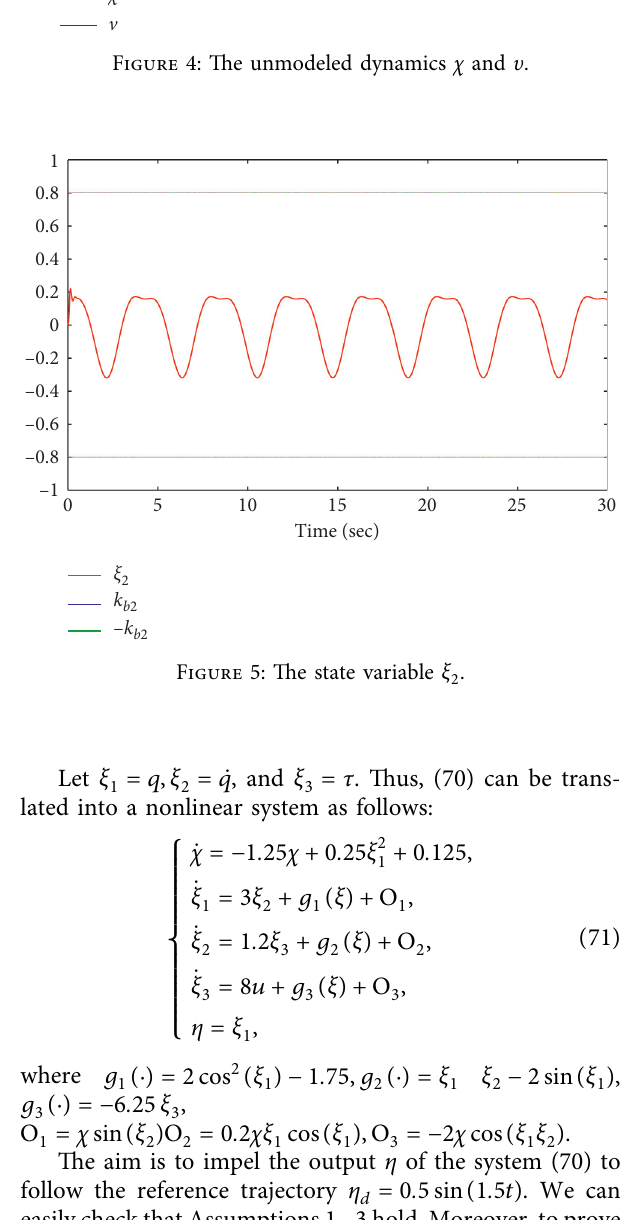
Figure 4: The unmodeled dynamics χ and υ .